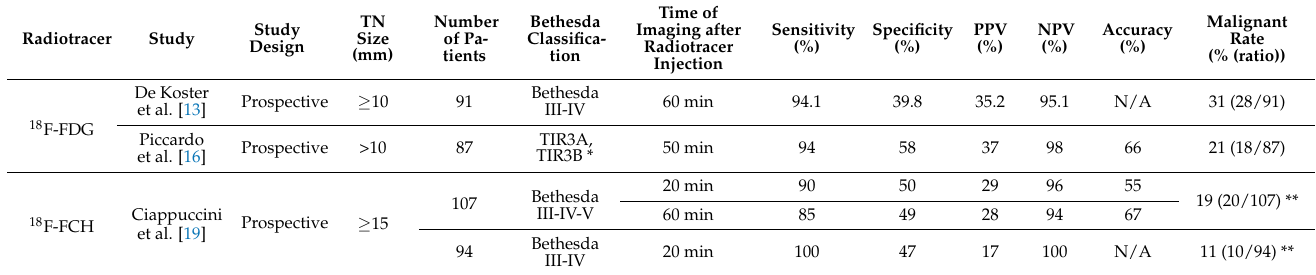
Table 1. Studies reporting PET/CT scan performance in identifying thyroid nodule histopathological